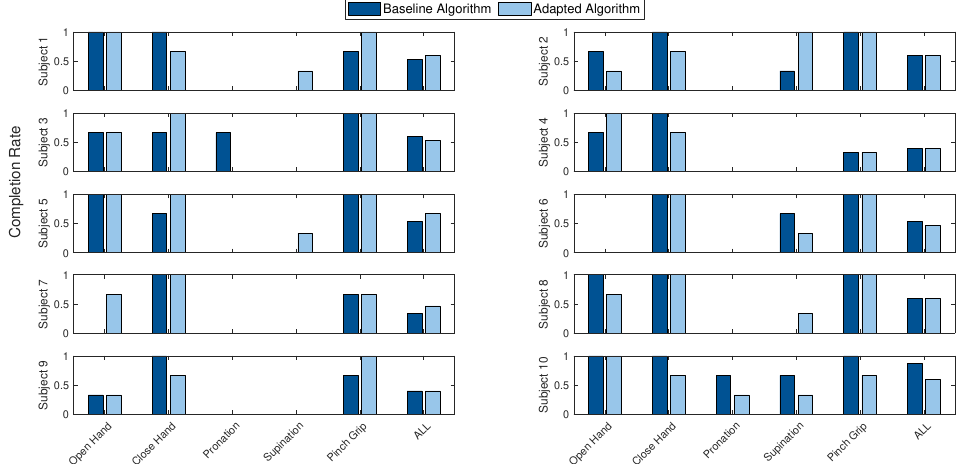
Figure 16. Hand motion-specific completion rate for all subjects and external loads. Box plots visualize median completion rate (red line), minimum and maximum completion rates (lower and upper end of whiskers) as well as the first and third quartile (lower and upper end of boxes).